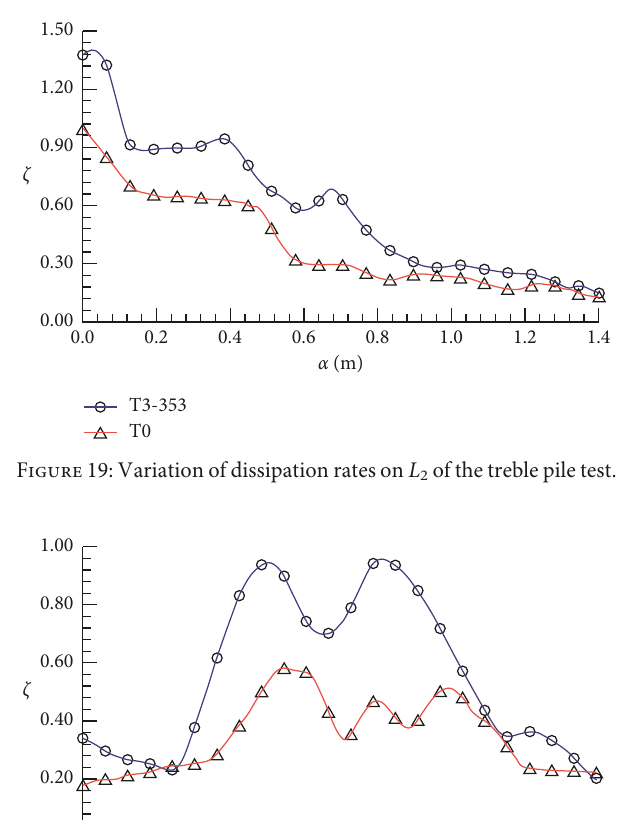
3 of the treble pile test.